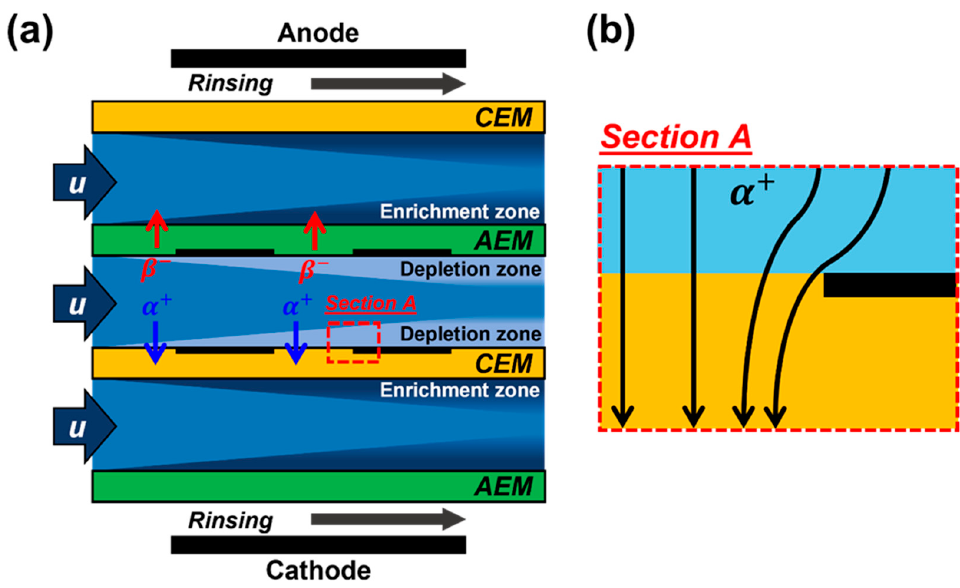
Figure 1. A schematic of electro-membrane desalination and the ionic current path. ( a ) Electrodialysis and ( b ) the ionic current path when an ion-exchange membrane is partially masked. Blue and red arrows indicate the transport of cations (alpha) and anions (beta) by the electric field. The less bright region shows the ion depletion zone and the darkest region shows the ion enrichment zone. An anion-exchange membrane (AEM) and a cation-exchange membrane (CEM) are used for counter-ion transport. Section A (red dotted box in the depletion zone near the CEM) is magnified on the right; it shows the modified cation path.